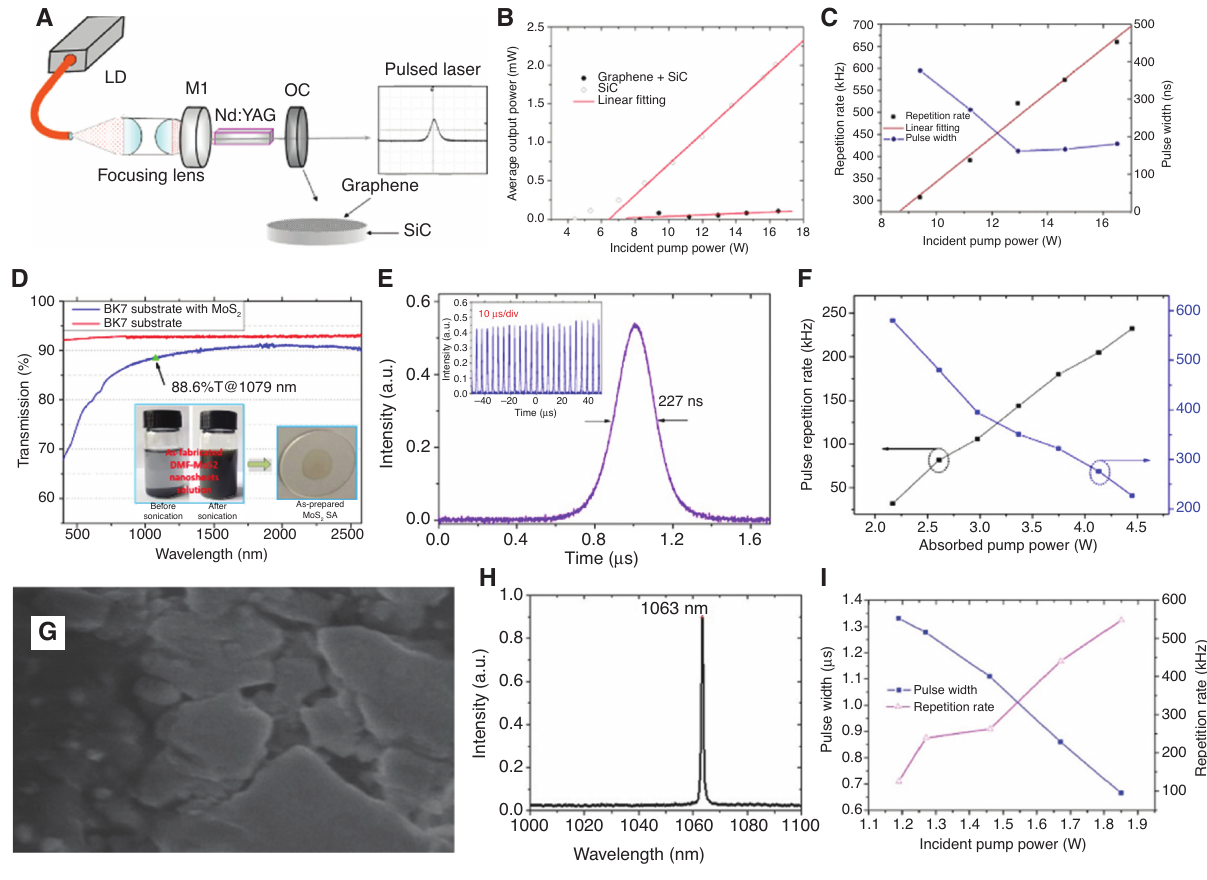
Figure 9: Q-switching solid-state lasers with layered material-based SAs. (A–C) Graphene. (A) Experimental setup of Nd:YAG pulsed lasers based on graphene. (B) Output power versus incident pump power. (C) Repetition rate and pulse width versus incident pump power. Reproduced with permission from Ref. [185]. Copyright 2010, American Chemical Society. (D–F) MoS . (D) Transmission spectra of the blank BK7 and MoS 2 of the Q-switched Nd:YAP laser and the pulse train (inset). (F) Evolution of the pulse repetition rate and the pulse width with the absorbed pump power. Reproduced with permission from Ref. [186]. Copyright 2014, Optical Society of America. (G–I) Bi Optical spectrum. (I) Evolution of the pulse repetition rate and the pulse width with the absorbed pump power. Reproduced with permission from Ref. [18]. Copyright 2013. John Wiley and